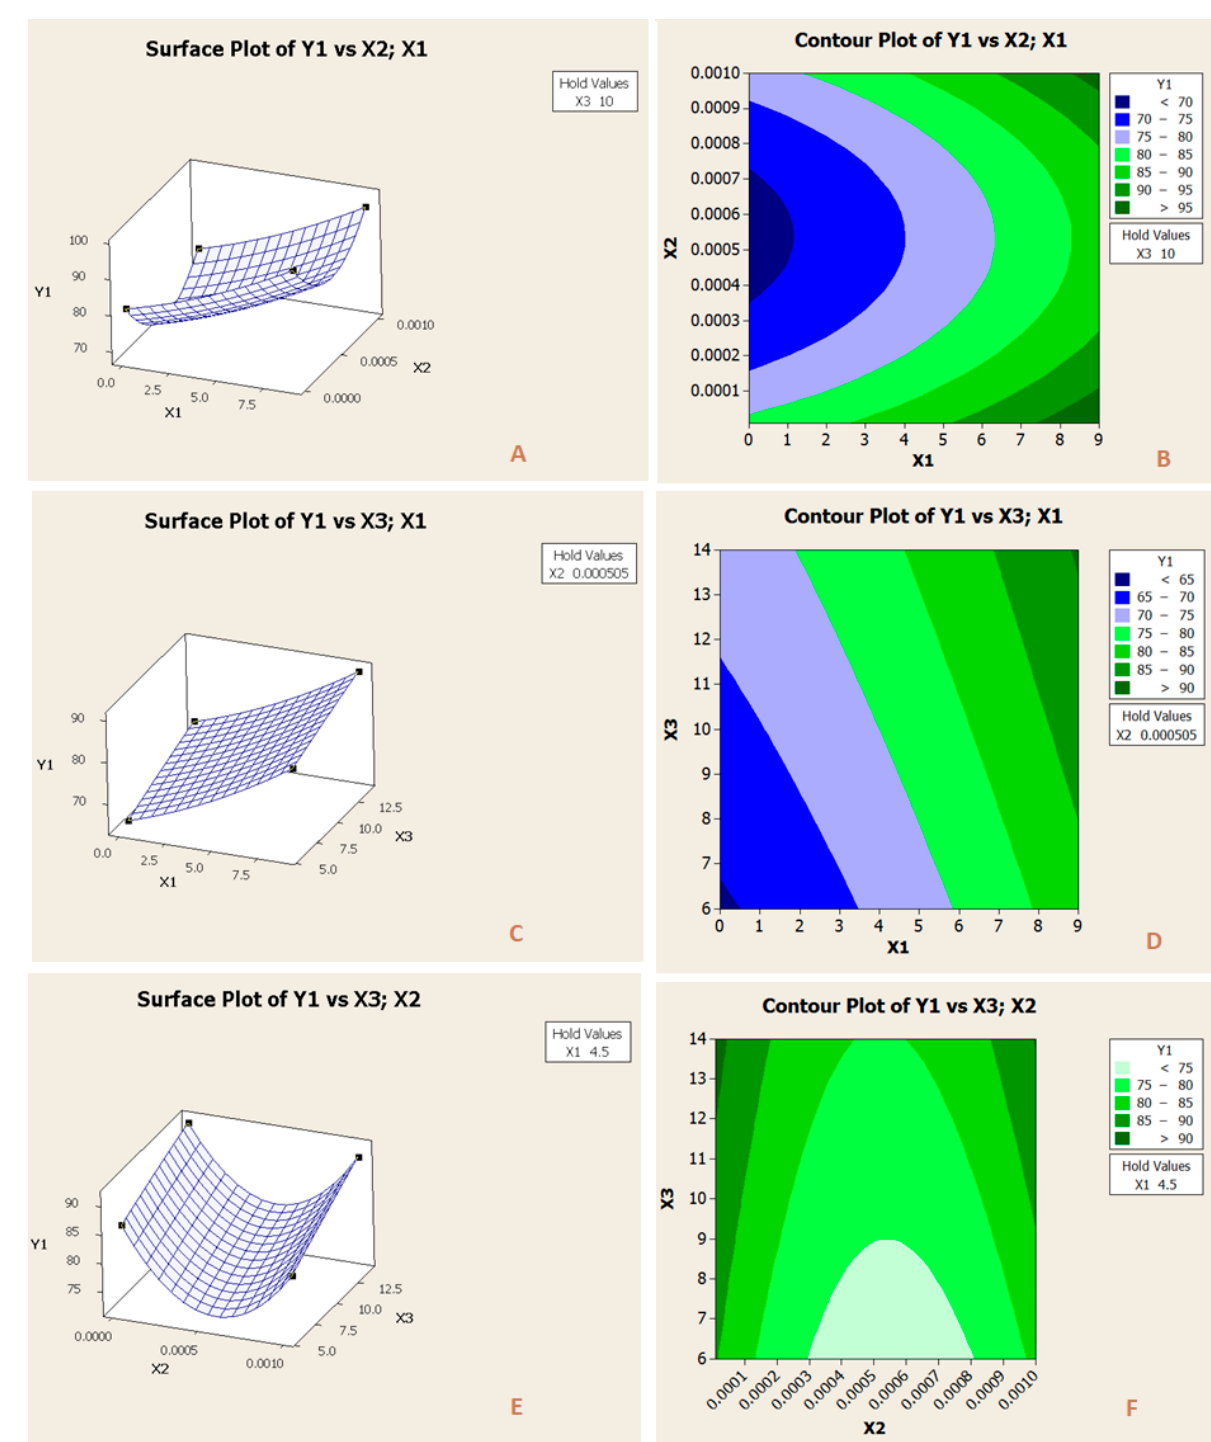
Figure 10. Surface plot ( A , C and E ), and contour plot ( B , D and F ) of the parameters impacts (PES concentrations ( x 1 ), feed concentrations (x 2 ) and pH (x 3 )) on rejection.